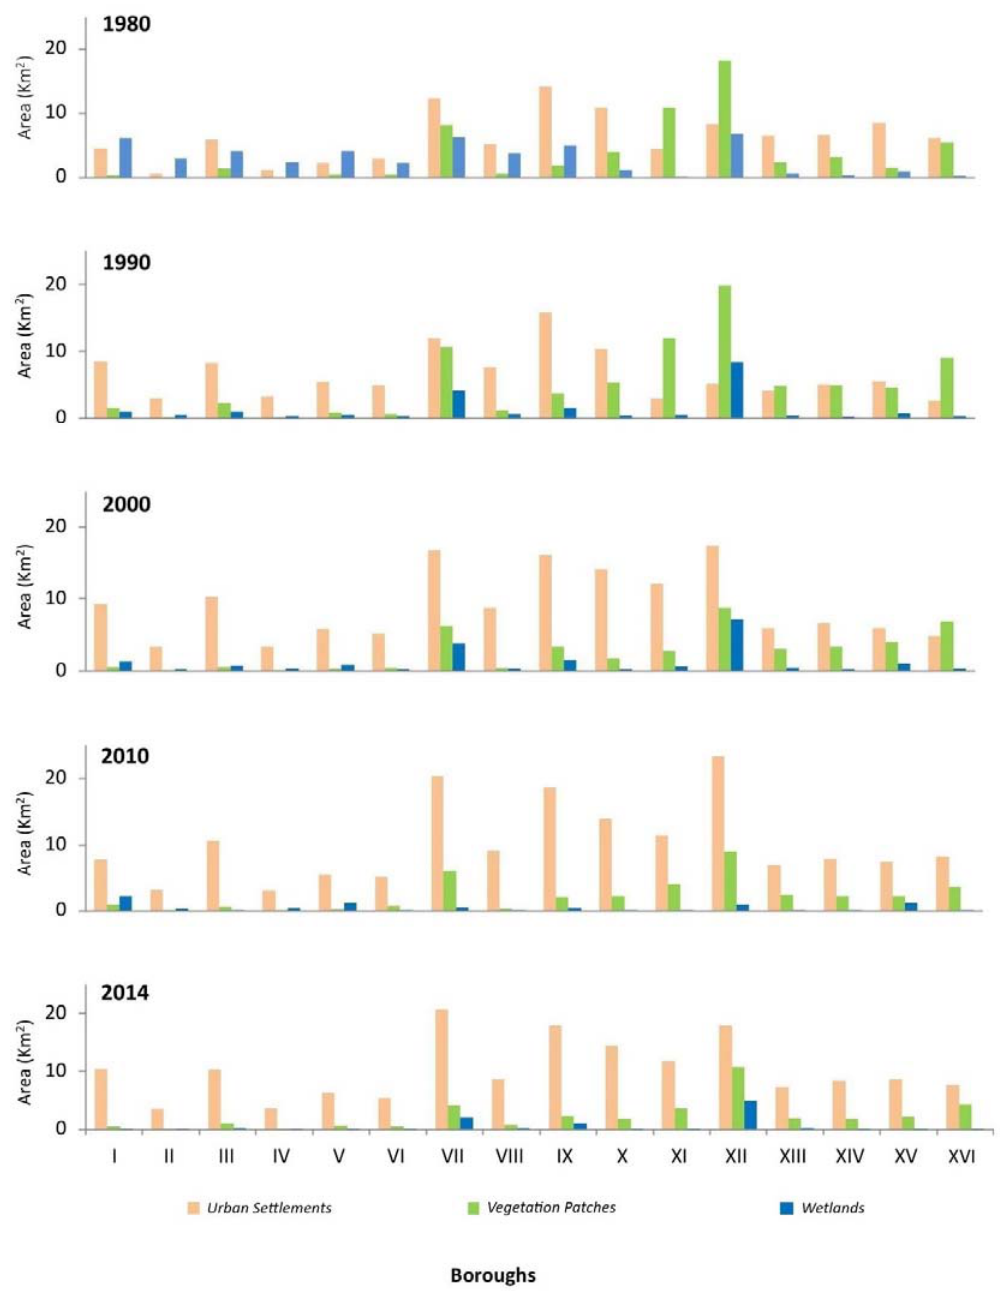
Figure 8. Borough-wise decadal distribution of the major land use-land cover classes (km 2 ) in Kolkata Municipal Corporation area (KMC) decade-wise since 1980 differentiated into (a) urban settlements (built-up and sealed areas), (b) vegetation patches and (c) wetlands . (Data base courtesy: Satellite Image interpretation from Landsat (USGS) and LISS III series (ISRO, India) and the Govt. of West Bengal, India).